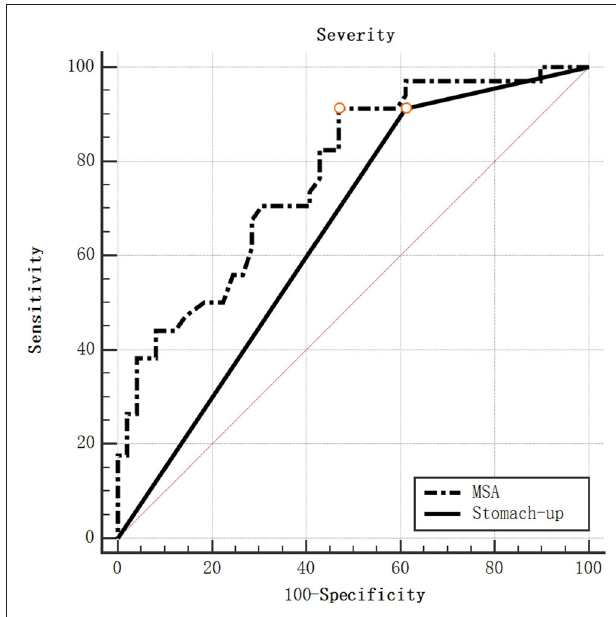
FIGURE 5 | ROC curve for severity by MSA value and